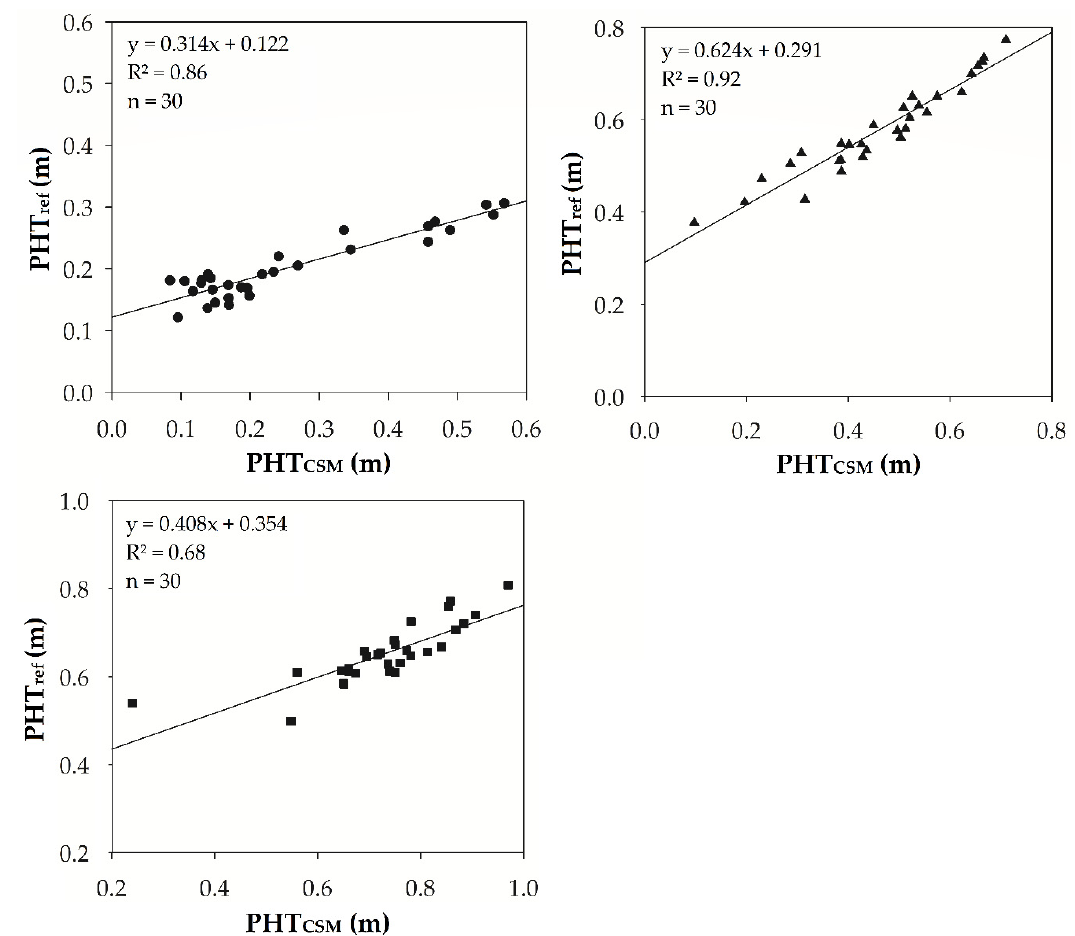
Figure 2. Linear regression between plant height deviated from CSM (PHT CSM ) and manual height measurements (PHT ref ) for each mission. p < 0.001 for all R² . Symbols indicate datasets from Mission 1 ( ● ), Mission 2 ( ▲ ), and Mission 3 ( ∎ ).